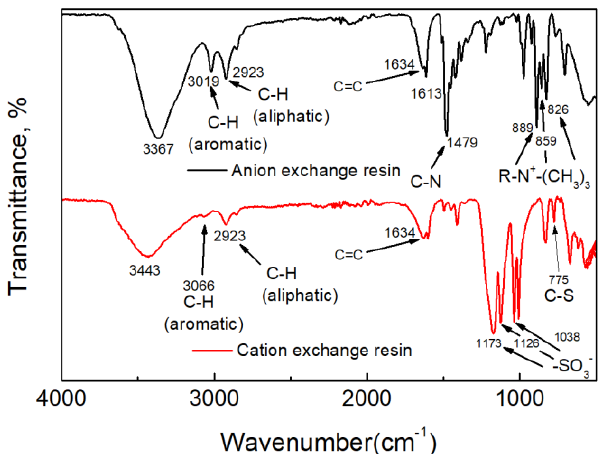
Figure 1. Fourier transform infrared (FT-IR) spectra of anion-exchange resins (AERs) (black) and cation-exchange resins (CERs) (red).